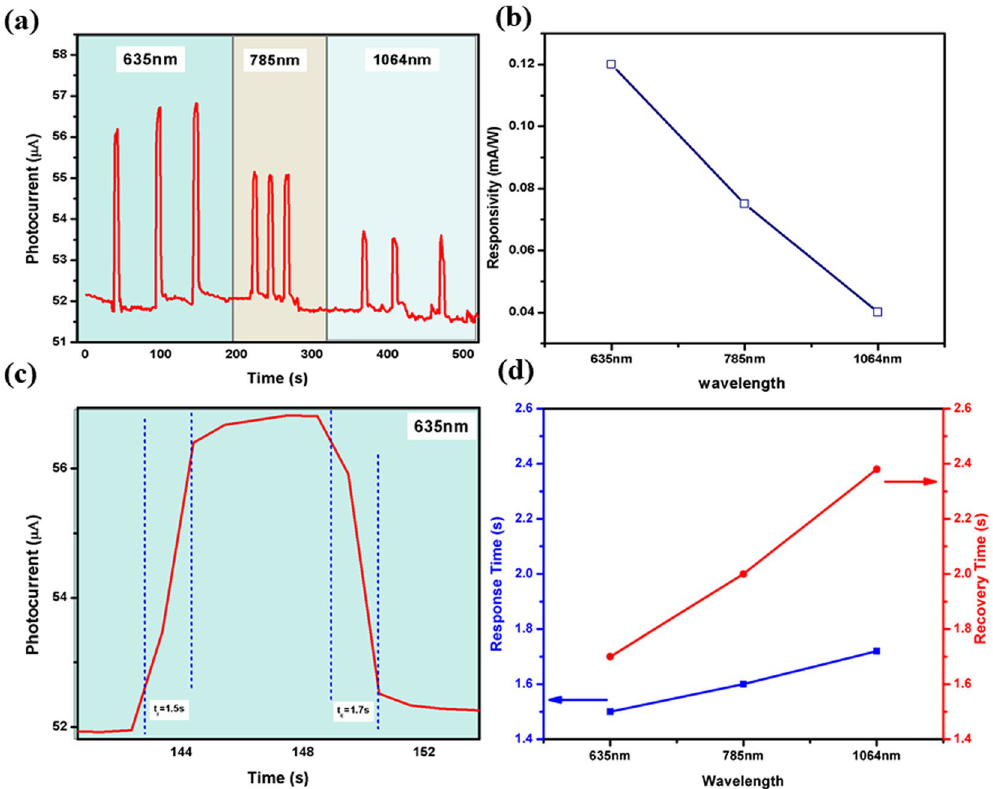
Figure 5. ( a ) The photocurrent vs time plot of rGO sensor for various excitation wavelengths: 635 nm, 785 nm, and 1064 nm ( b ) corresponding photoresponsivity of sensor illuminated under different wavelengths, ( c ) response and recovery time of sensor when illuminated with 635 nm wavelength laser, and ( d ) response and recovery time as a function of excitation